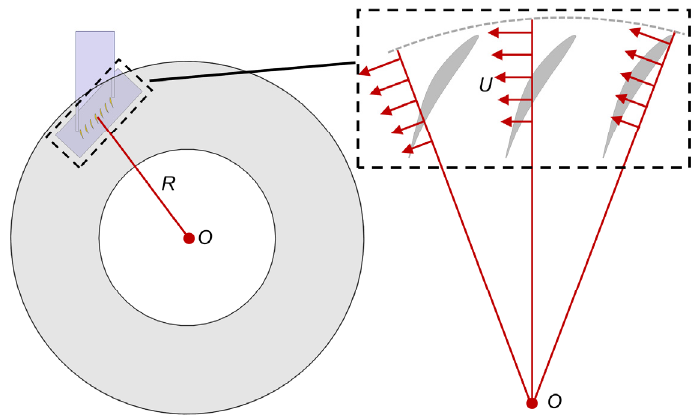
Figure 2. Schematic of linear velocity change with the radius.